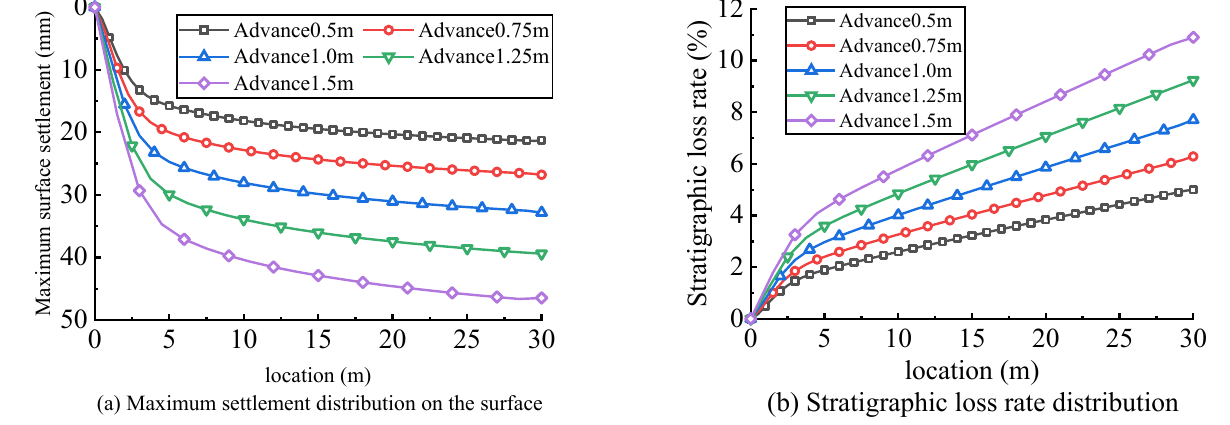
Figure 10. Influence of the excavation footage length on the formation deformation distribution.